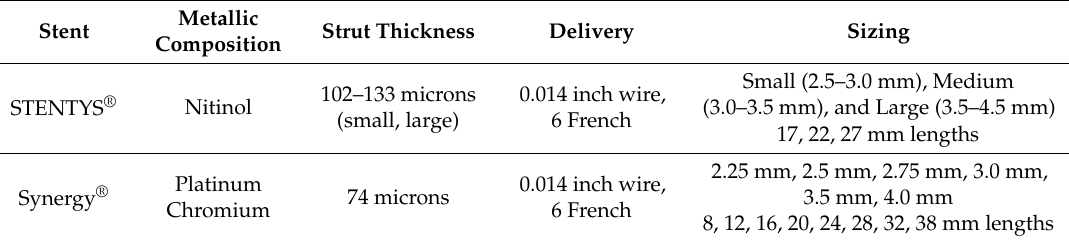
Table 2. Comparison of self-expanding coronary stent with balloon expandable